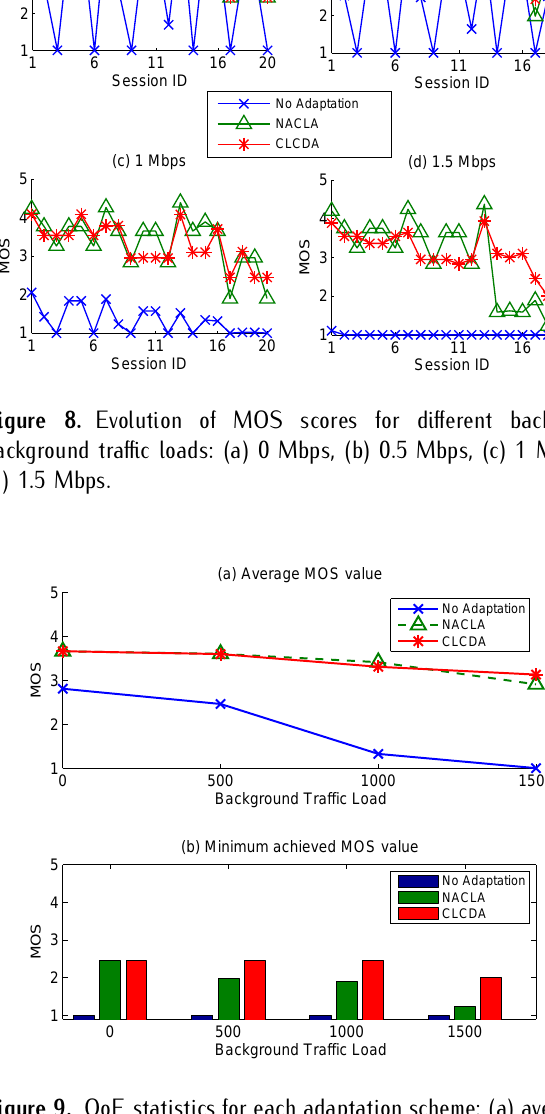
Figure 9. QoE statistics for each adaptation scheme: (a) average MOS, (b) minimum